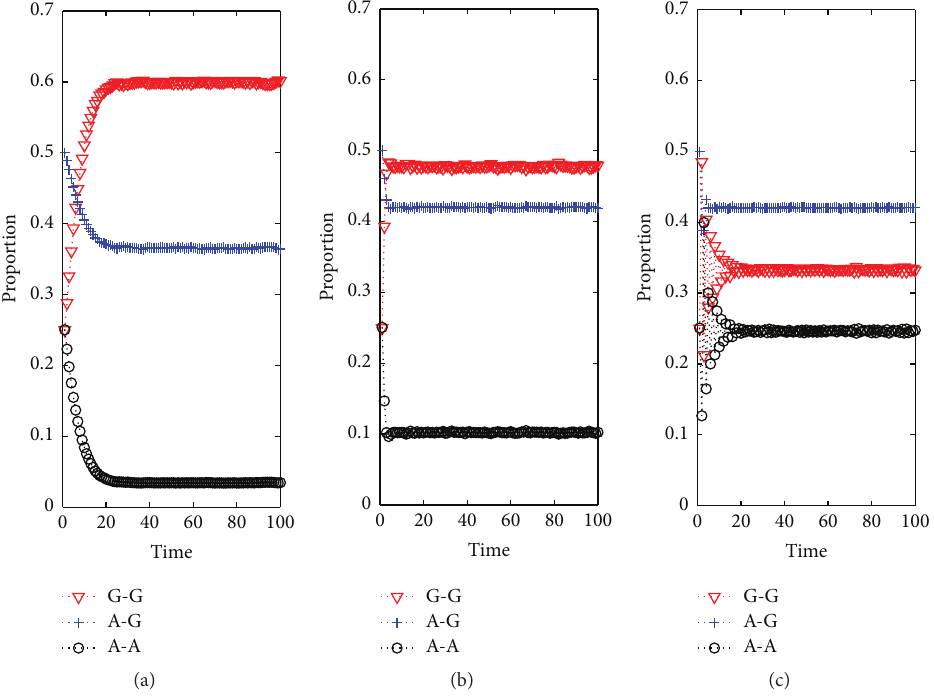
Figure 9: The proportion evolution of link: (a) 𝐸 = 20 , (b) 𝐸 = 30 , and (c) 𝐸 = 50